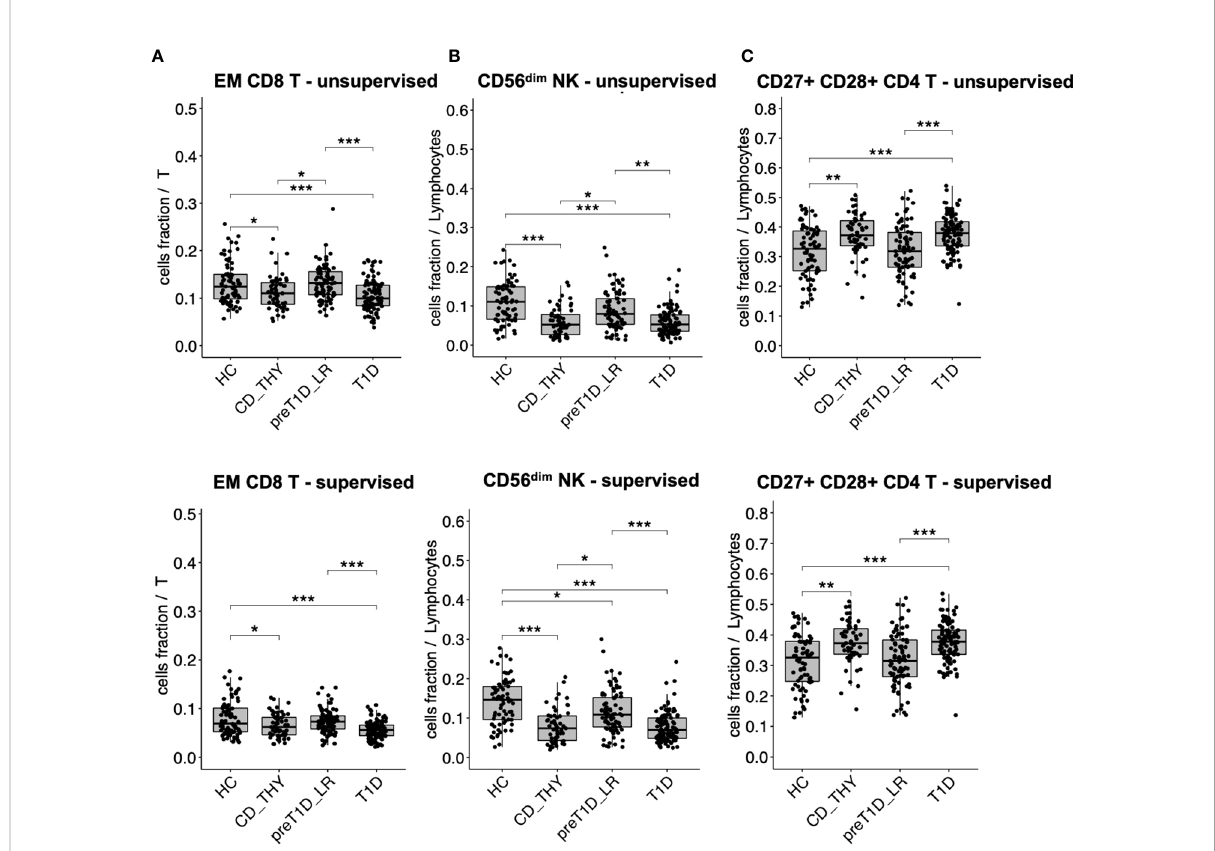
FIGURE 3 Cell populations altered in multiple autoimmune diseases. Cell subsets showing a reduced (A, B) or increased (C) frequency in the circulation of both patients with T1D and with celiac disease or autoimmune thyroiditis. HC, healthy controls; CD_THY, celiac or thyroid diseases; preT1D_LR, relatives with 0-1 autoantibodies; T1D, type 1 diabetes. Signi fi cant differences were determined by post hoc Tukey ’ s test performed on the linear regression model with age, sex, and technician as covariates (*p < 0.05, **p < 0.01, ***p <